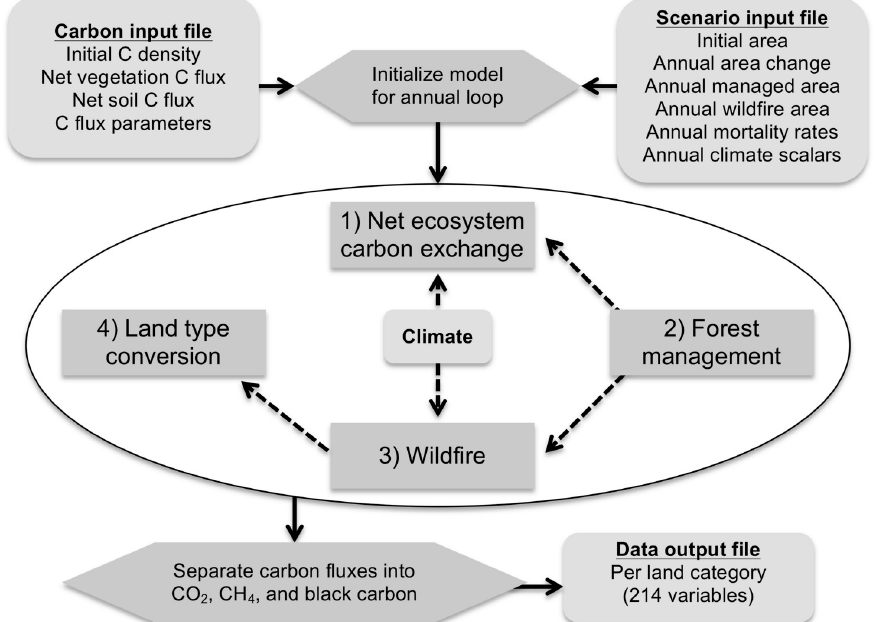
Fig 3. CALAND model structure. The CALAND model calculates annual changes in landscape carbon and associated fluxes of CO 2 , CH 4 and black carbon. The four main processes are implemented in numbered order and the carbon state is updated after each process. Net ecosystem carbon exchange includes the effects of relevant management practices and optionally the effects of climate change. Forest management includes disposition of harvested, fuel- reduction, and urban forest mortality biomass. Wildfire area is specific to the selected climate option. Land type conversion includes various restoration types, reforestation, and afforestation in addition to baseline land use and land cover change. Direct interactions among the processes are shown by dashed arrows.